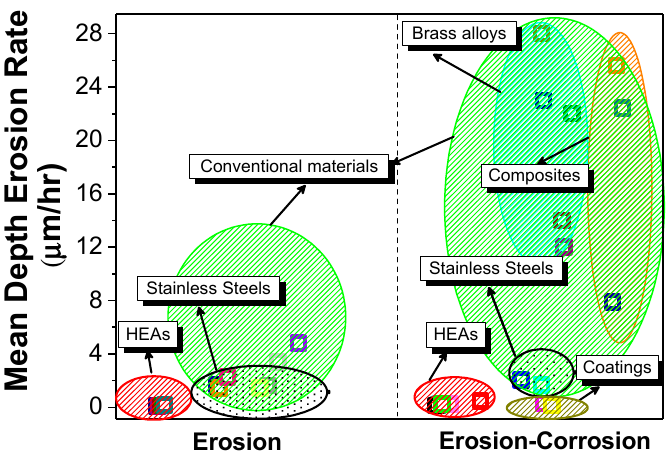
Figure 23. Comparison of high entropy alloys with conventional structural materials for erosion and erosion-corrosion resistance. “Conventional materials” in the figure refers to a broad range of materials developed for erosion/corrosion applications such as SS304 [28,50], SS304L, mild steel, Bainitic Steel [86] and Copper Alloys [87]. “Coatings” refer to coatings on AA6061 [88] for erosion mitigation.